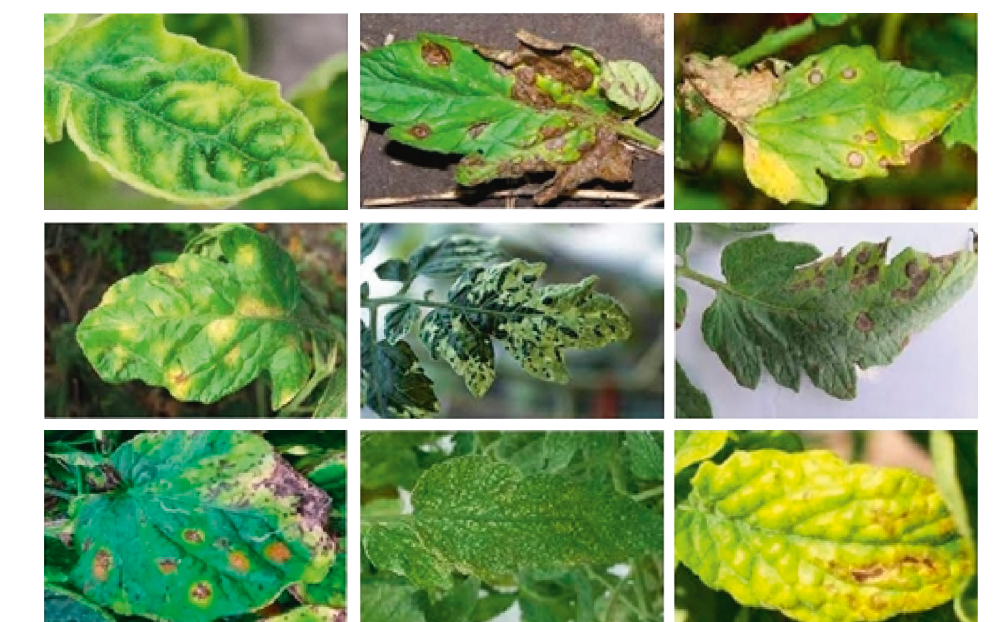
Figure 2: Some images of the leaves from the TomatoDB dataset.